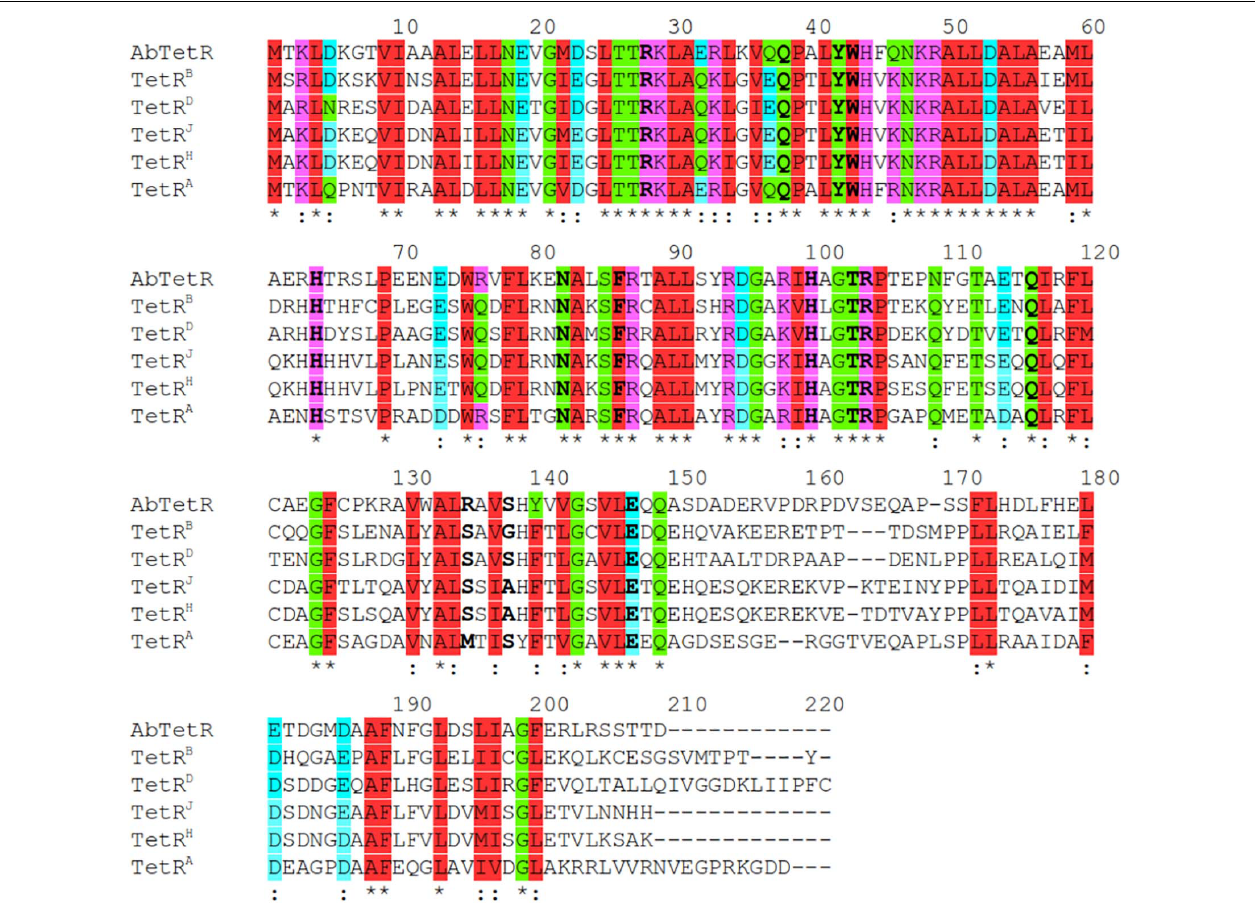
FIGURE 5 | Protein sequence alignment of TetR members. AbTetR: TetR class G of A. baumannii AYE (Genbank accession number: CAM88408); TetR B : TetR class B of transposon Tn 10 (Genbank accession number: ELD20529); TetR D : TetR class D of Escherichia coli (Genbank accession number: P0ACT4); TetR J : TetR class J from Proteus mirabilis (Genbank accession number: AAD12754); TetR H : TetR class H from Pasteurella multocida (Genbank accession number: CAA75662); TetR A : TetR class A from Pseudomonas sp. (PDB: 5MRU). Substituted residues are indicated in bold.